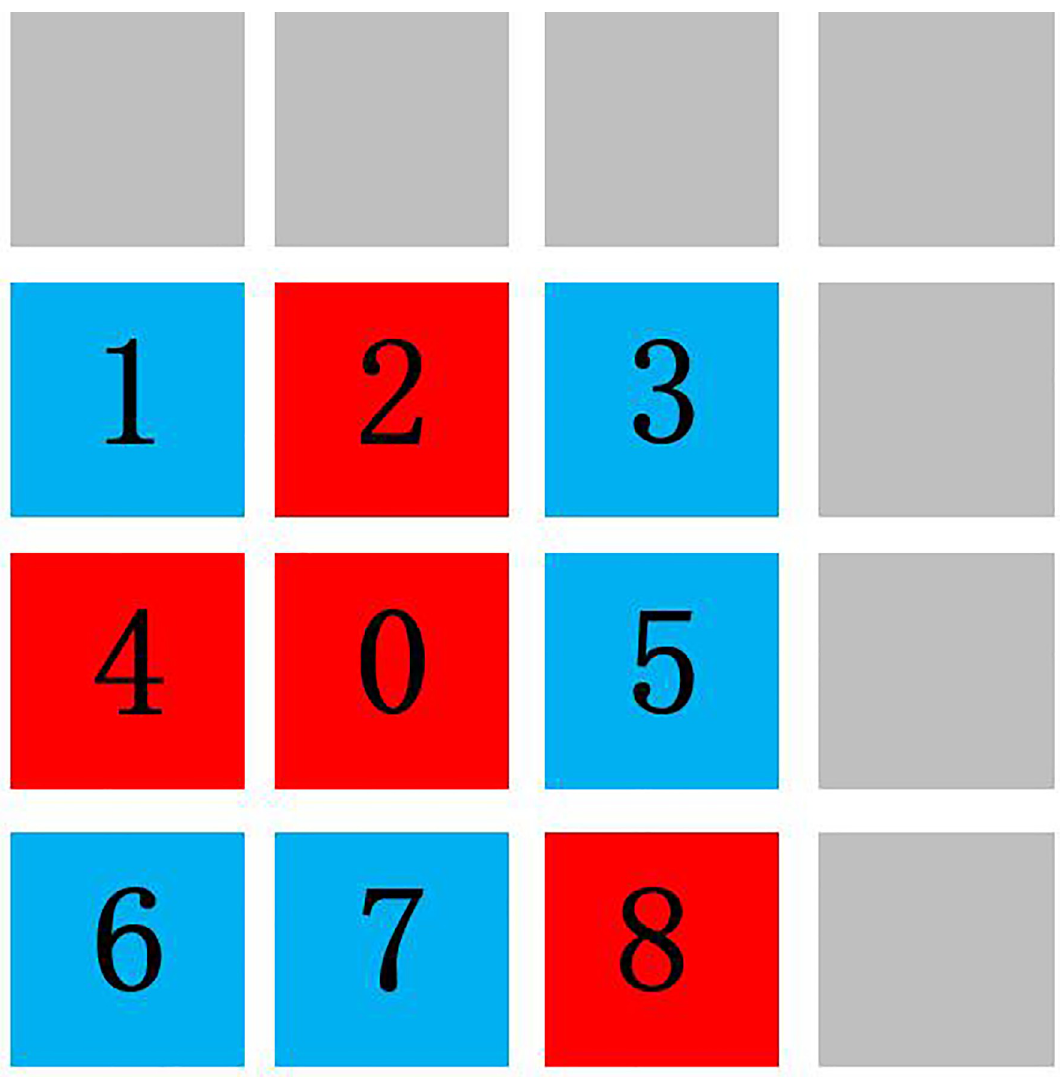
Fig 3. Seed point from mapping for crack region